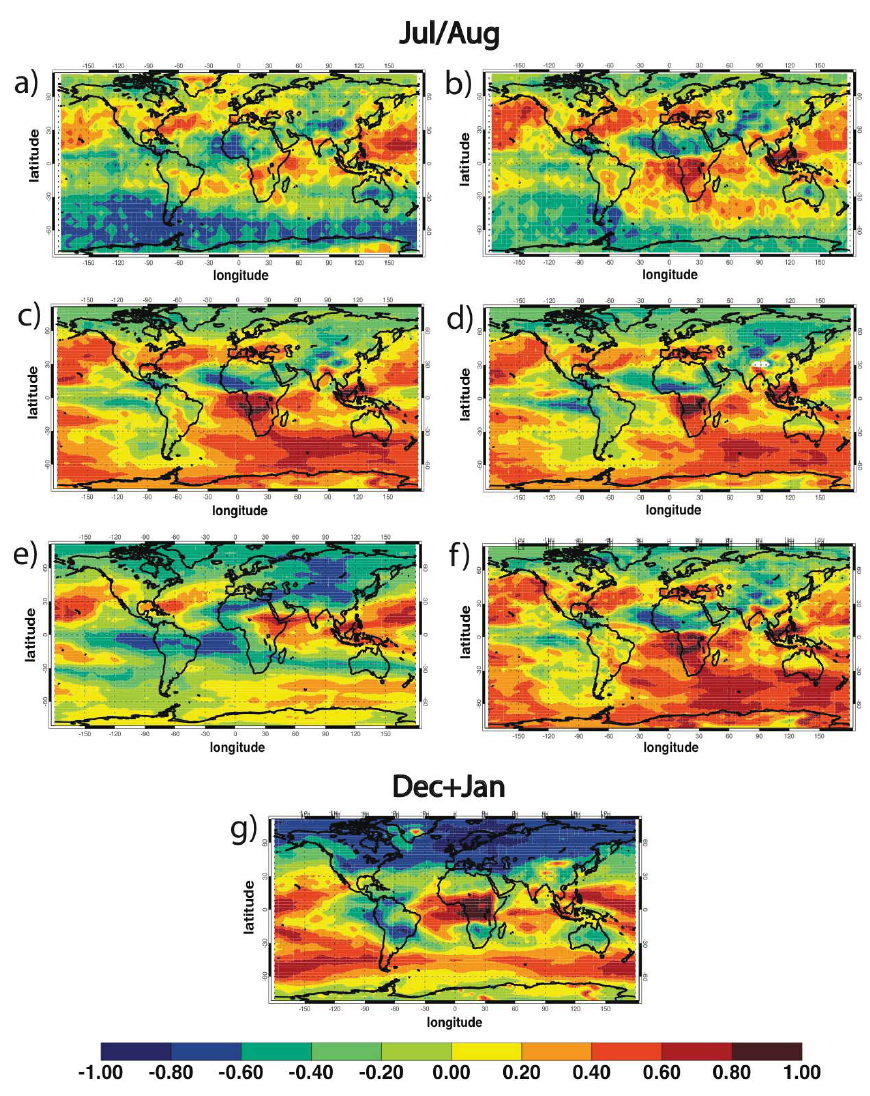
Fig. 7. Testing the robustness of UKCA 2005–08 correlation coefficients seen in Fig. 3: (a) same as Fig. 3e but without the observational error; (b) same as (a) but without the TES operators application; (c) same as (b) but without the TES sampling (i.e. raw model output); (d) same as (c) but for 562hPa instead of 800–400hPa average; (e) same as (c) but for 316hPa instead of 800–400hPa average; (f) same as (c) but calculated using 5-daily (quasi-weekly) averages instead of daily. Also, we show the correlations from the raw model output for December–January in (g) (compare with Fig.